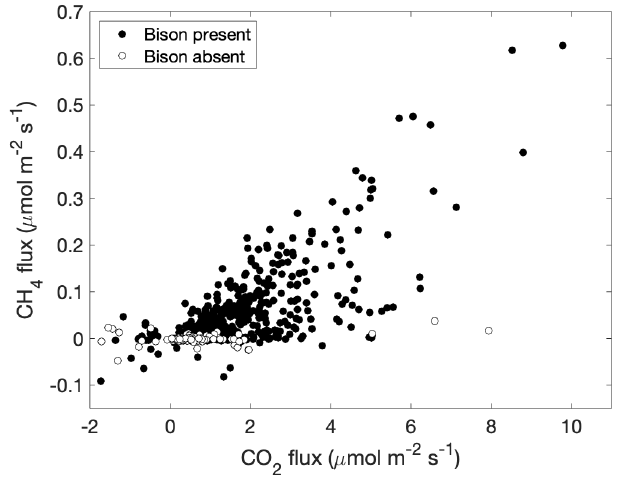
Figure 7. The relationship between carbon dioxide and methane fluxes from the study pasture is shown for periods when bison were present (filled circles) and when bison were absent (open circles).